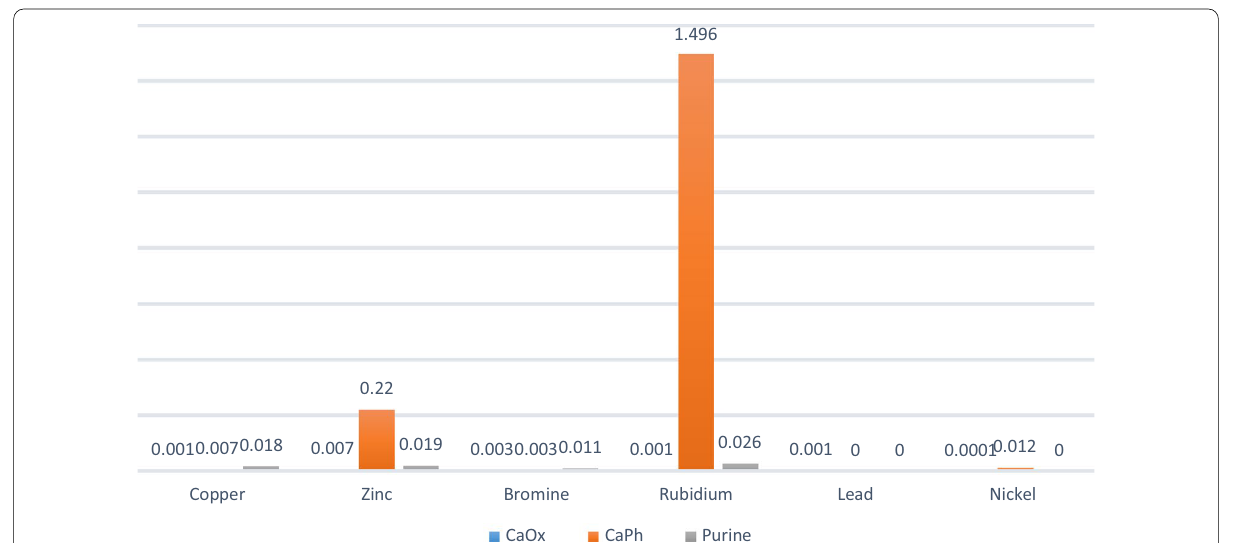
* Likelihood ratio chi-square